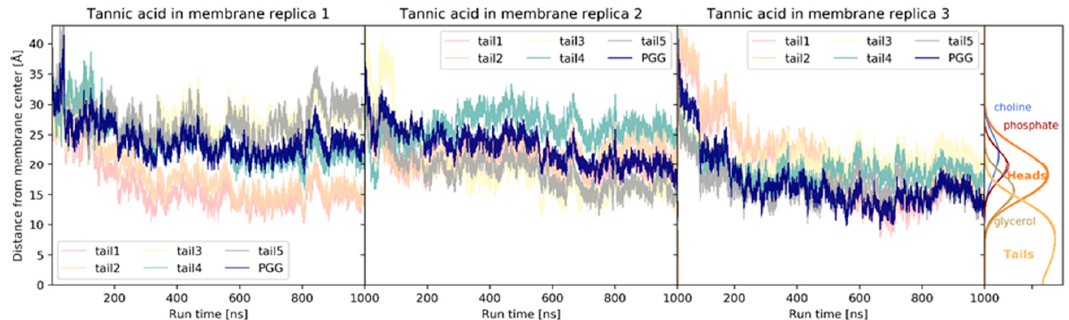
Figure 12. The six different representative structures of tannic acid in the membrane, according to the clustering analysis. The PGG is in blue, the five different gallic acid tails are in different colours. Oxygen atoms are in red, and hydrogen atoms in white. The membrane is depicted as spheres with the phosphatidylcholine headgroups in dark orange with hydrogens and oxygens; the tail carbon atoms are pale orange spheres.